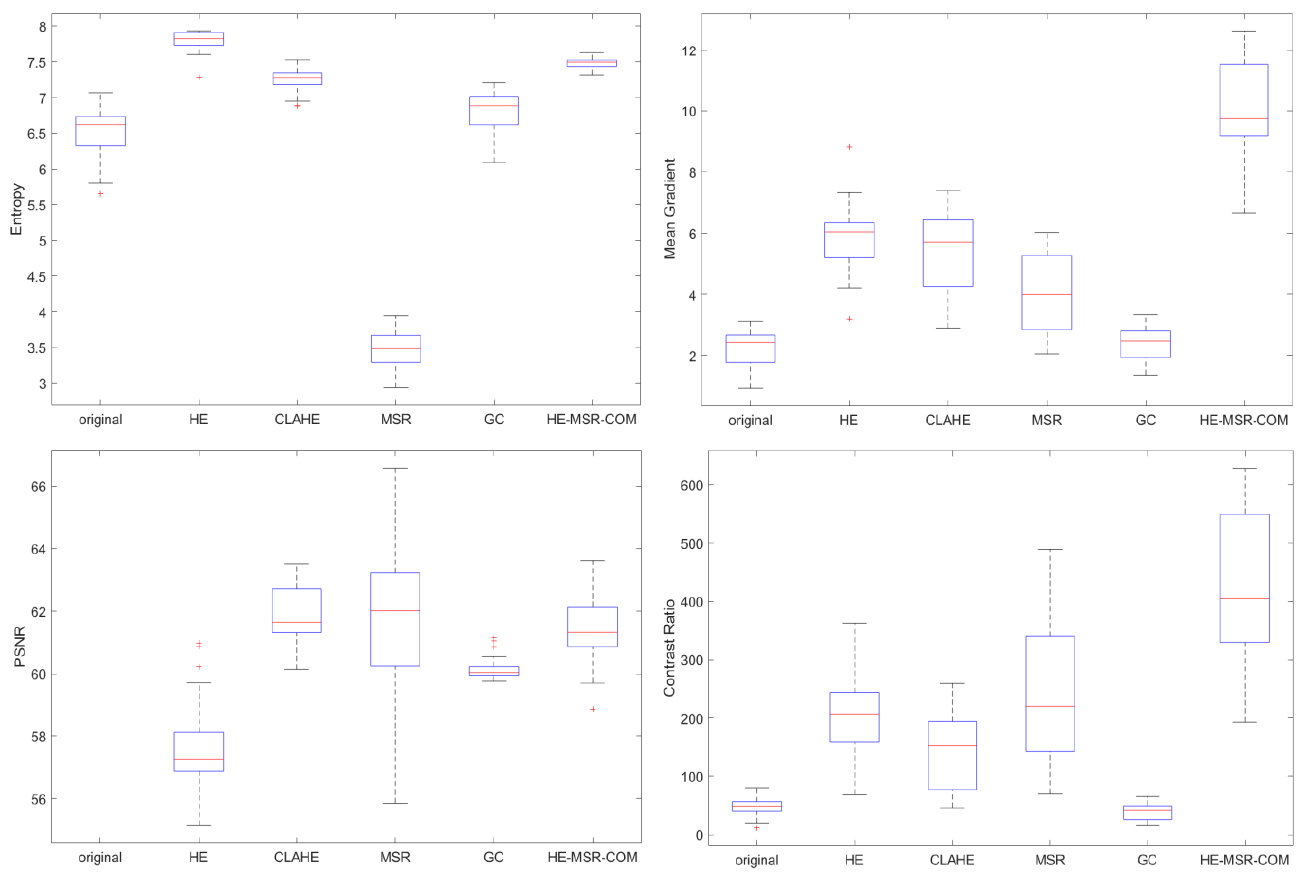
Figure 8. Evaluation distribution in GTA5.